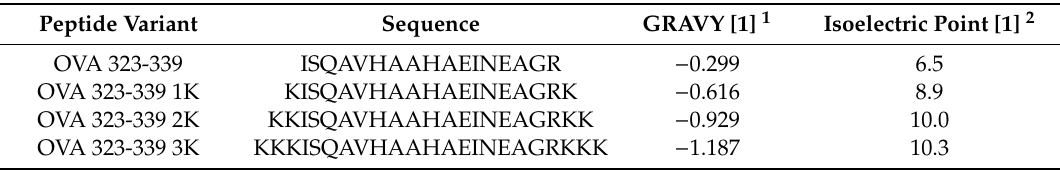
Table 1. Sequences and physico-chemical properties of the model T helper cell peptides. Peptide Variant